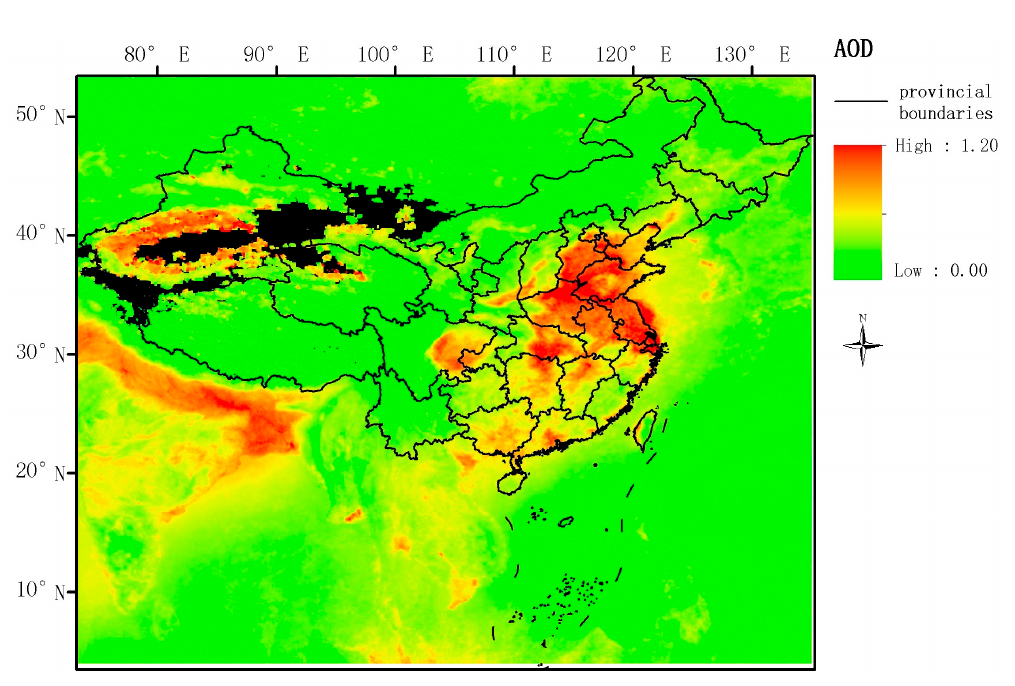
Figure 9. Yearly mean AOD values for China. The data source and the processing method are presented in Section 2.4. The data shown in Figure 9 are used as inputs for the evaluation model of relative random errors.